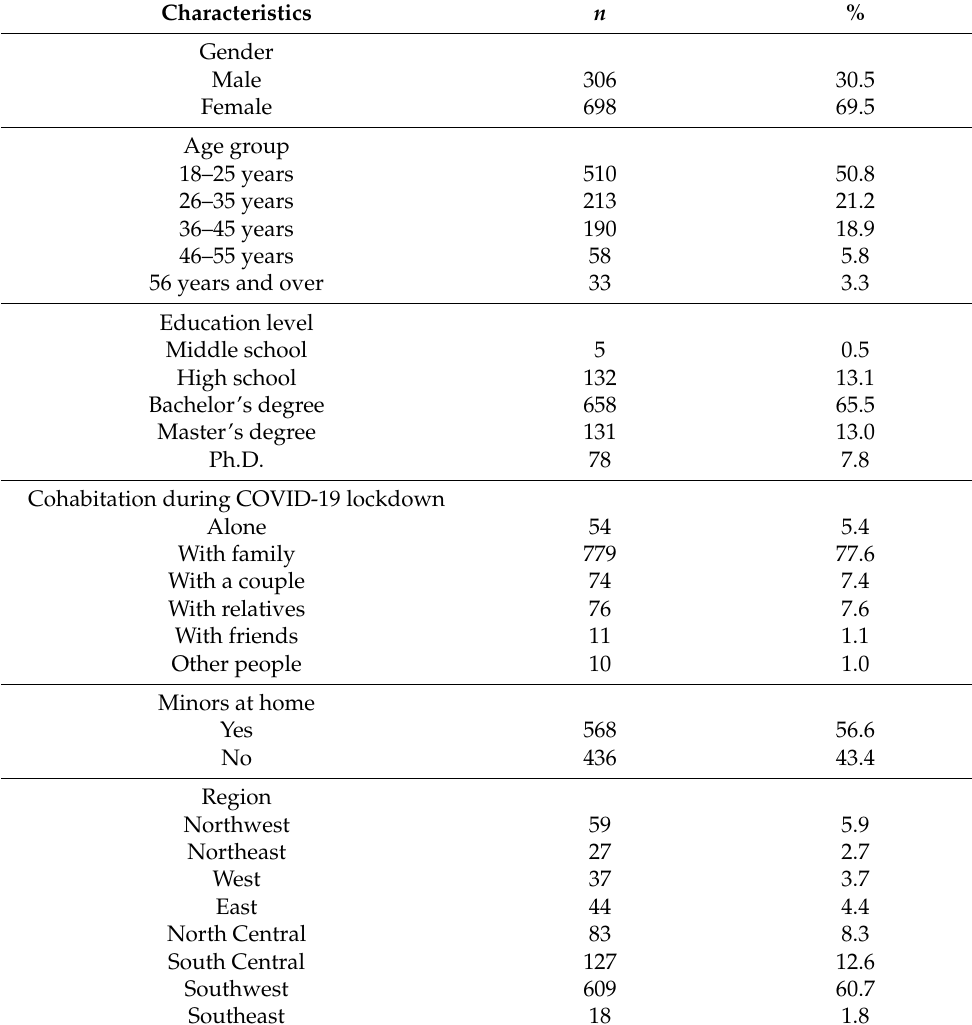
Table 1. Demographic characteristics of study participants ( n =